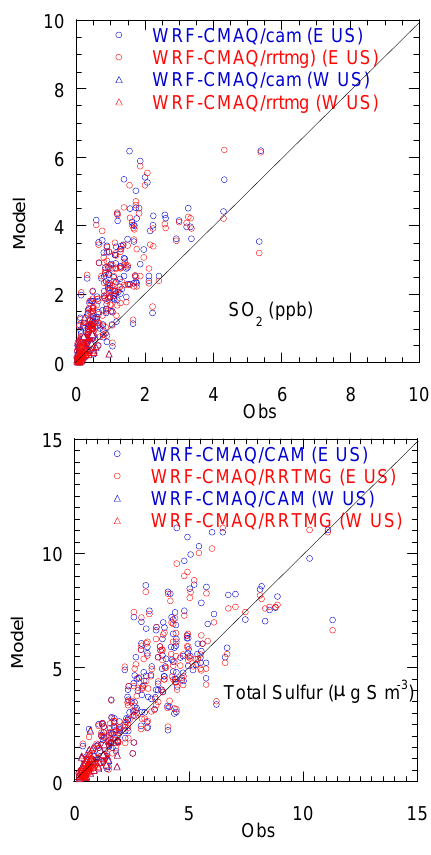
Figure 8. Comparison of observed and modeled (WRF– CMAQ/CAM and WRF–CMAQ/RRTMG) SO 2 and total sulfur (SO 42- +SO 2 ) concentrations at the CASTNet over the continental United States.